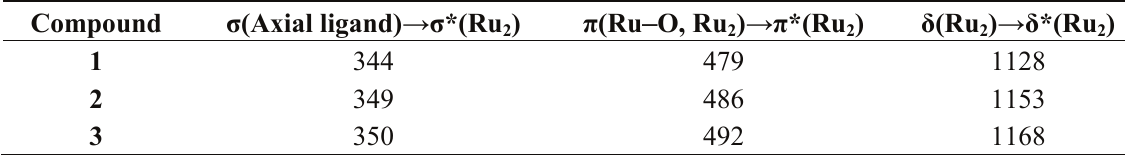
Table 2. Electronic spectra data (nm) for compounds 1 – 3